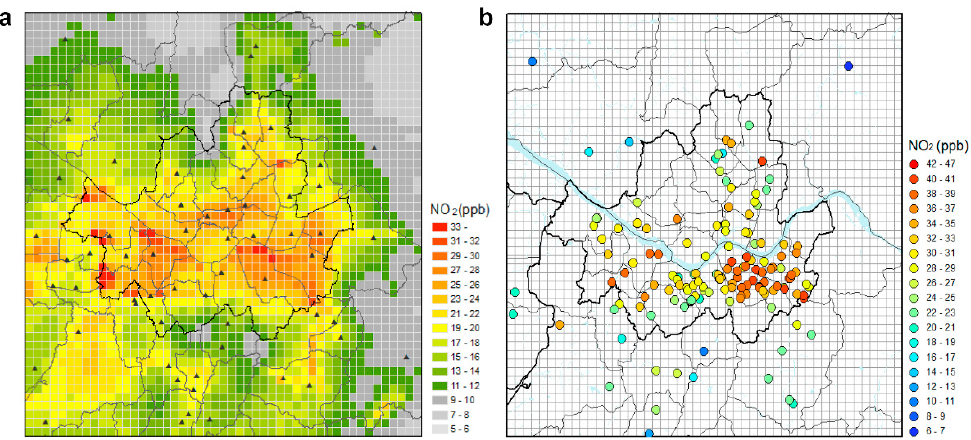
Figure 3. Spatial distribution of CMAQ-NO 2 concentrations. Average CMAQ-modeled NO 2 concentrations during the study period ( a ) and NO 2 levels on July 28, 2014 ( b ). Black triangles indicate 60 AQM stations. Colored circles represent the residential areas of each atopic dermatitis patient.